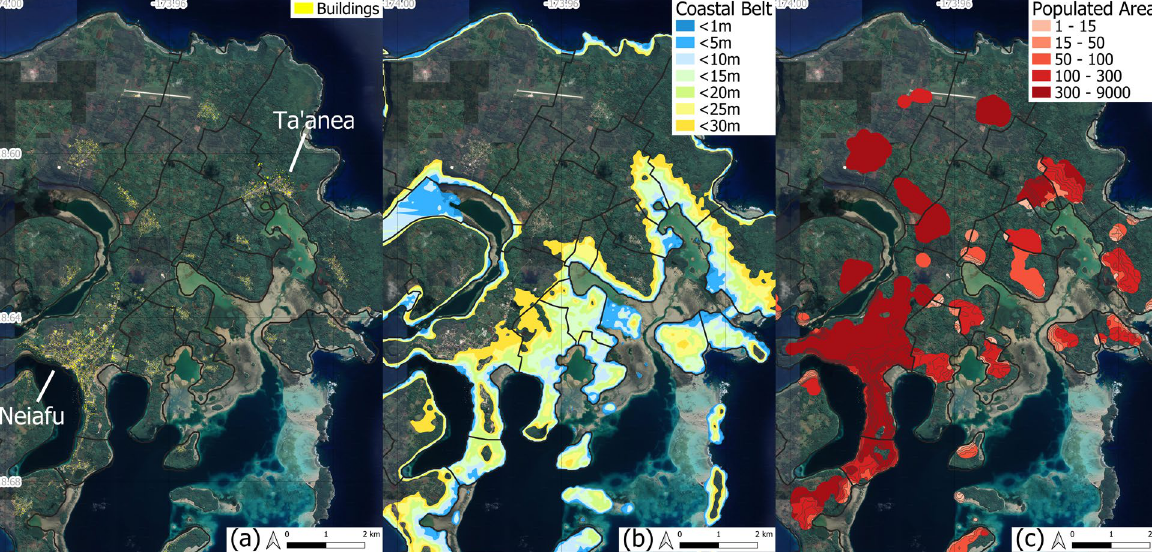
Fig. 6 Example of dasymetric maps produced for locating populated areas in Tonga. a Buildings layer on Google Earth imagery background. b Coastal belts below 30 m elevation. c Coastal populated